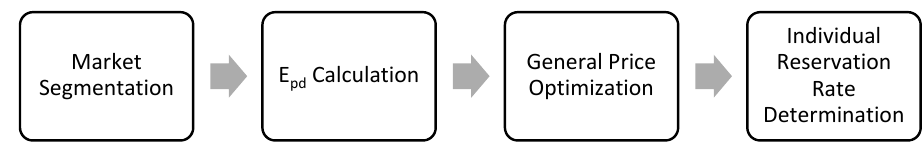
Figure 1. Process of Price Optimization and Setting.